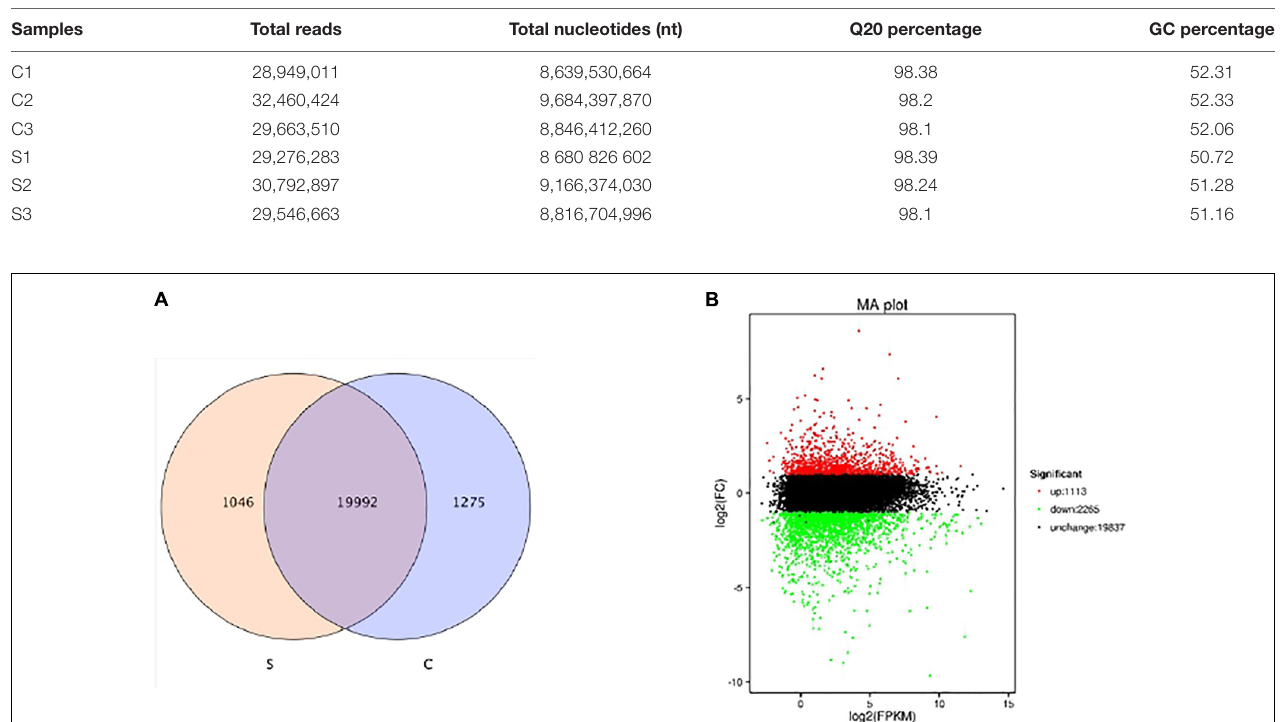
FIGURE 3 | Survey of expressed genes (A) and gene expression level (B) of BD banana between the salt stress-treated with 60 mM of NaCl and control libraries. Reel dots represent transcripts more prevalent in the library of salt-treated one, green dots show those present at a lower frequency in salt-treated plant and black dots indicate transcripts that did not change significantly.